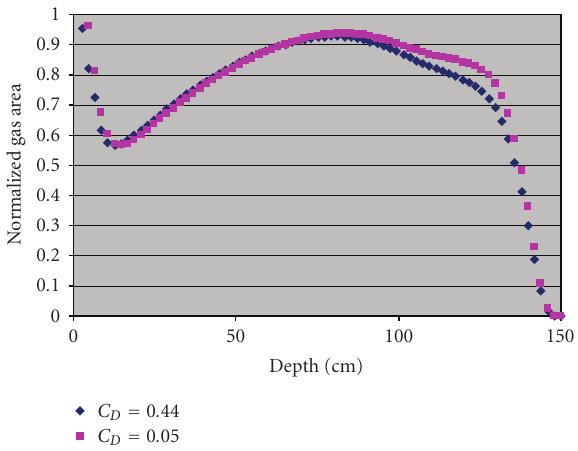
Figure 5: Normalized gas area as a function of the depth below the water surface.